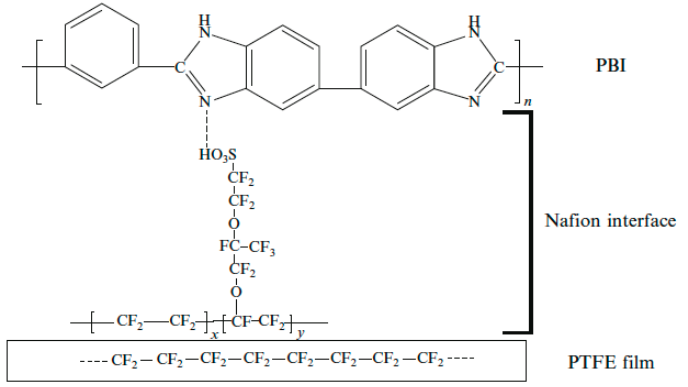
Figure 6. The role of Nafion™ as the coupling agent in PTFE-PBI composite membranes (taken from Ref. [67]).